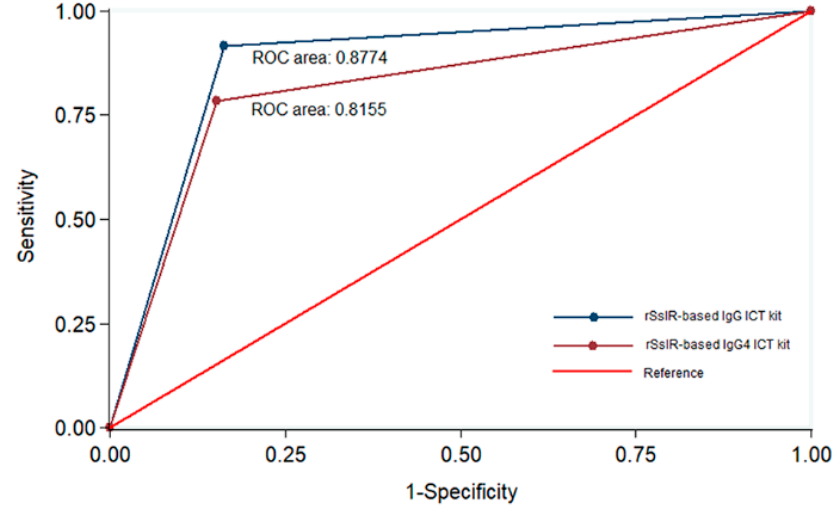
Figure 3. Comparative accuracy between the rSsIR-based IgG ICT kit and the rSsIR-based IgG4 ICT kit. The graph displays sensitivity (true positive rate) of test values on the Y -axis and 1-specificity (true negative rate) on the X -axis. ROC; Receiver Operating Characteristic. Table 1. Results by type of serum sample .